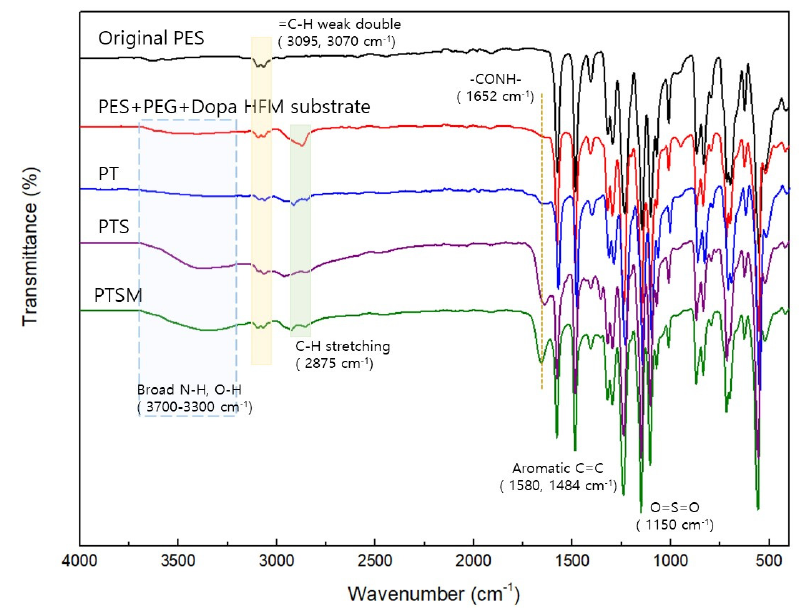
Figure 3. ATR-FTIR spectra of the thin-film composite hollow fiber membranes.